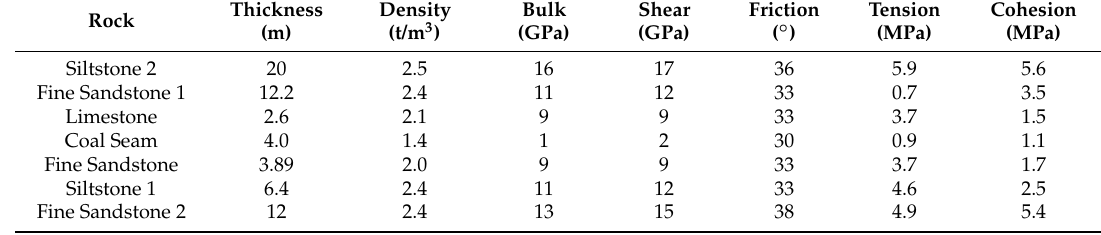
Table 1. Basic physical and mechanical parameters of rock.